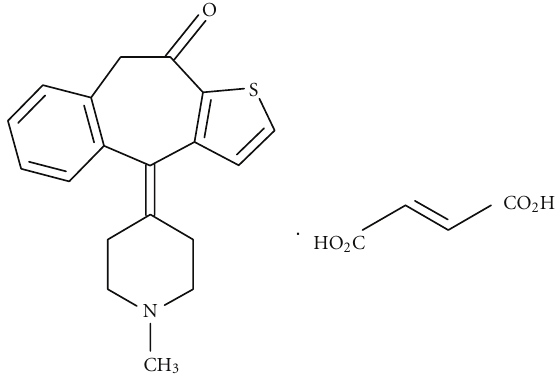
Figure 1: Structural formula of ketotifen